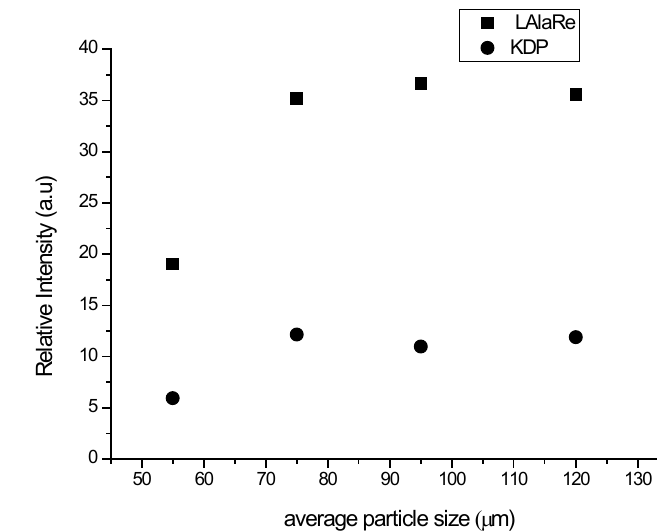
Figure 6. Second harmonic optical response of L-alaninium perrhenate